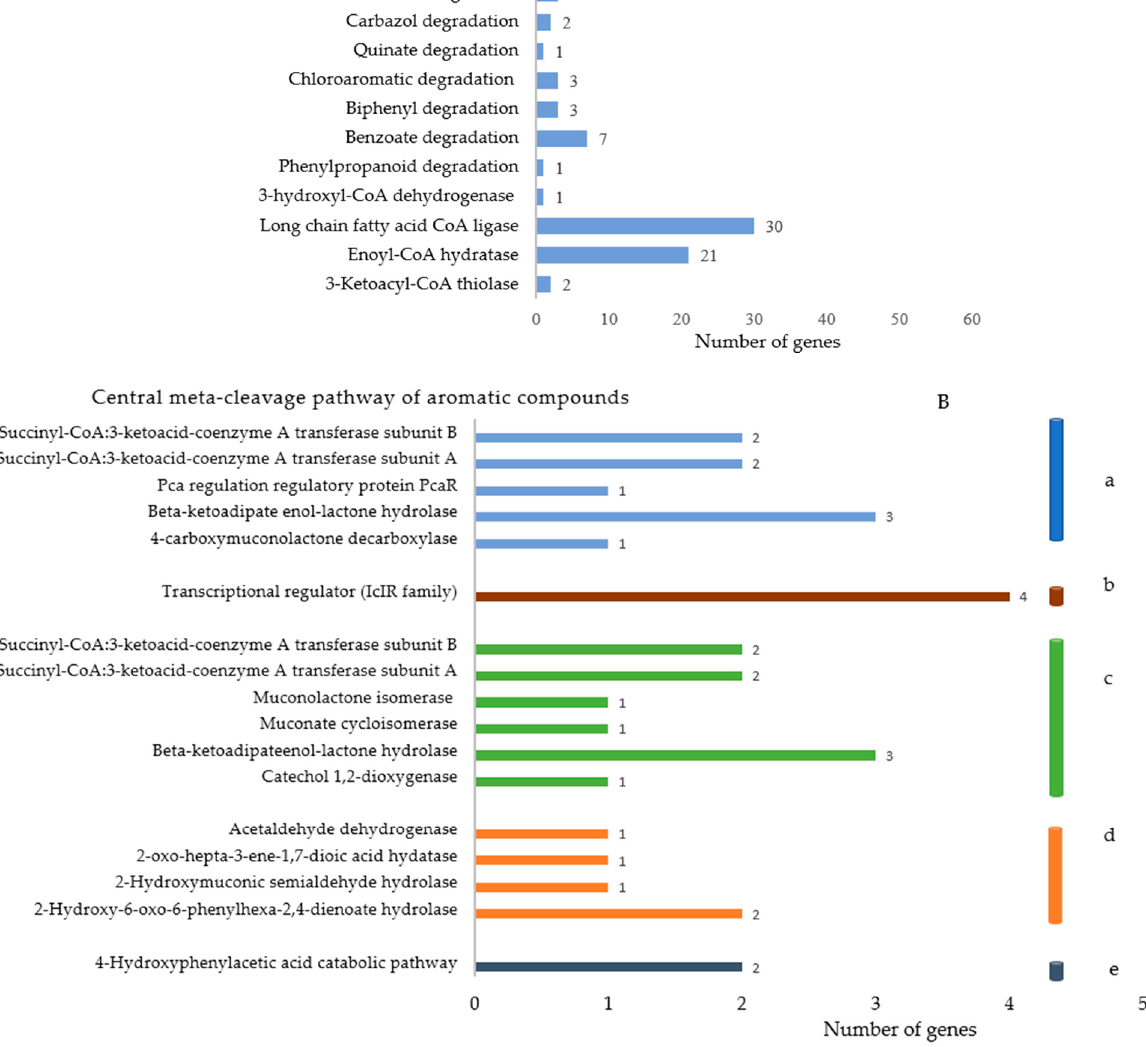
Figure 6. Number of genes involved in the catabolism of the aromatic compounds in D. psychralcaliphila JI1D by the peripheral ( A ) and central meta-cleavage ( B ) pathways, respectively (Table 2). Hydroxyphenyl acetic acid catabolic pathway.